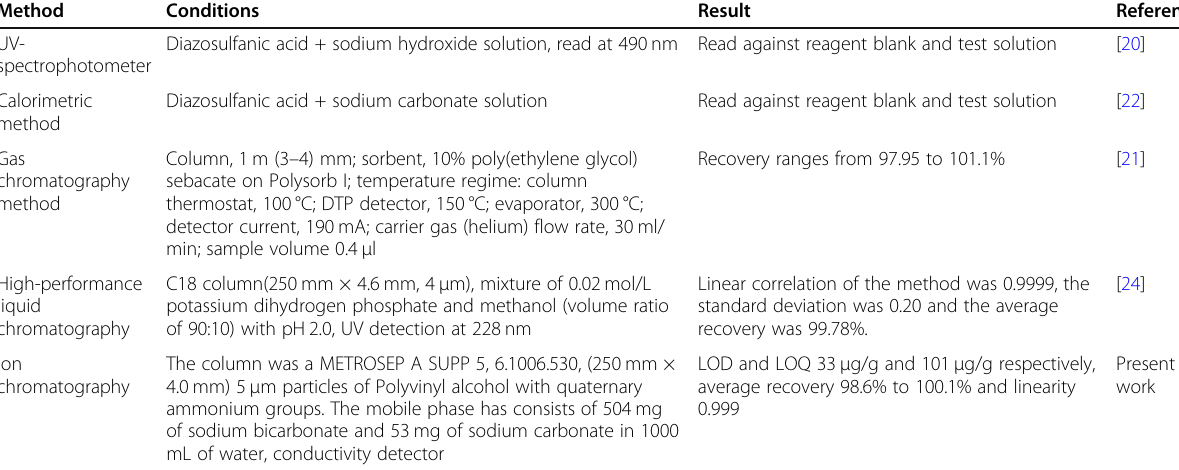
Table 8 Comparison of various methods for determination of CAA with published results in the literature Method